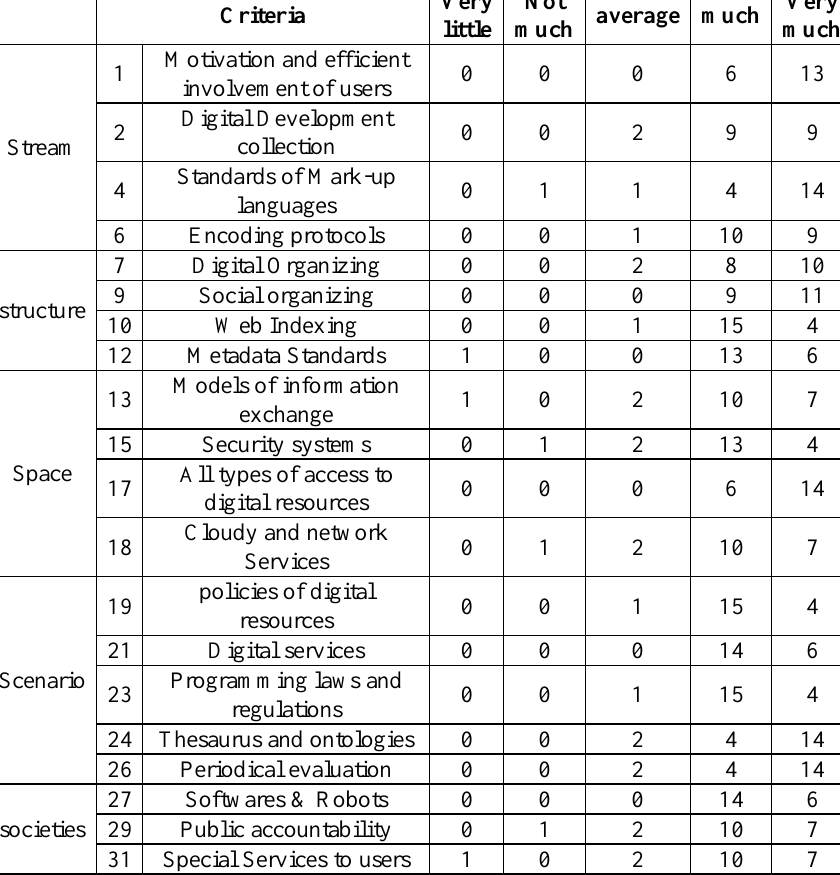
Table 4.Results of counting the answers of the poll's second